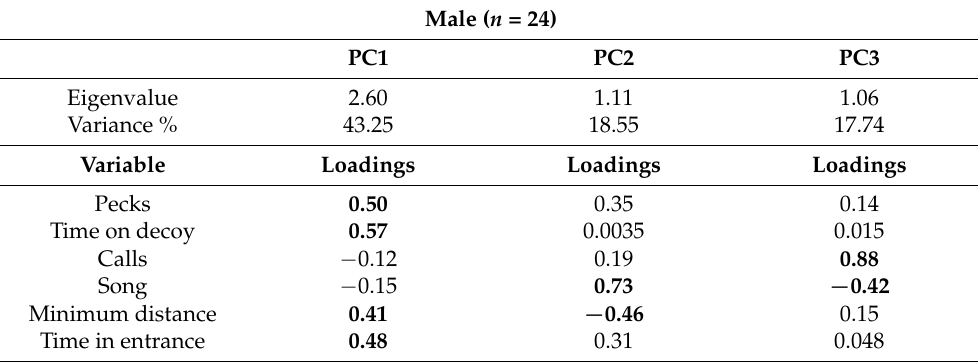
Table 2. Results from the principal component analysis for males, including eigenvalues, percentage of variance explained, and factor loadings. Data include responses on both male ( n = 24) and female ( n = 24) decoys. The minimum distance is reversed (multiplied by − 1), so larger values indicate more confrontational aggression. Similarly, the factor loadings for PC1 are reversed (multiplied by − 1) for the same reason. Variables with loadings greater than 0.40, deemed important for the construction of the components, are highlighted in